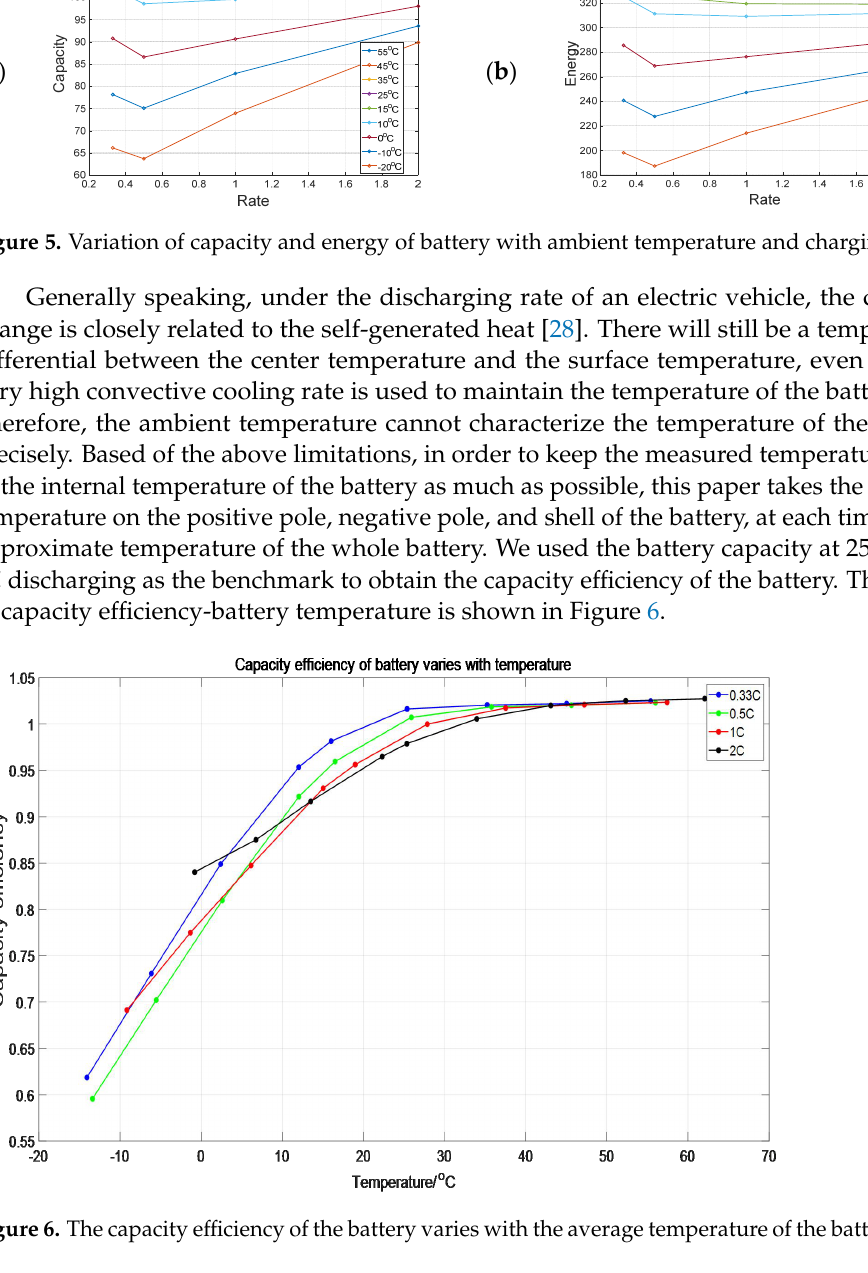
Figure 4. Schematic diagram of discharge experiment flow.